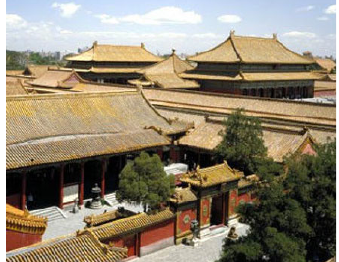
Figure 1 Bird-eye view of Yangxin Hall complex